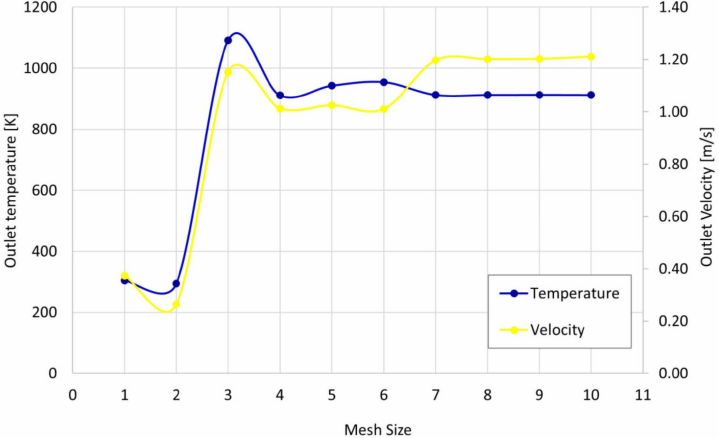
Figure 2. Results of mesh independence